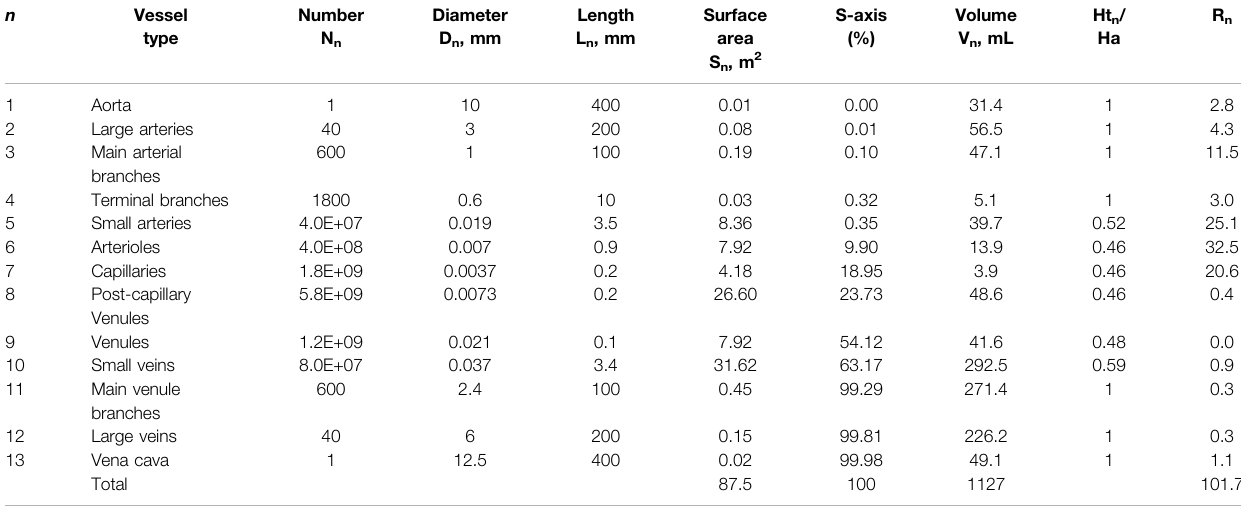
TABLE 1 | Morphometry and hemodynamics of a central vascular tree a (Rothe 2011). n Vessel